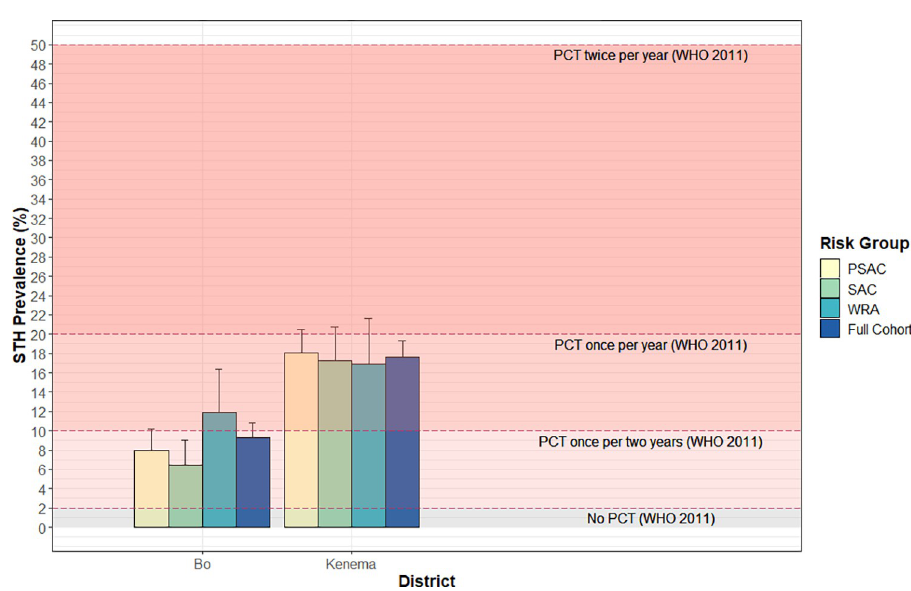
Fig 2. Soil transmitted helminthiasis prevalence by World Health Organization target risk group and thresholds for post-reassessment MDA frequency. STH: soil transmitted helminthiasis; PSAC: pre-school age children; SAC: school-age children; WRA: Women of Reproductive Age; Prevalence thresholds taken from Helminth control in school-age children : A guide for managers of control programmes . 2nd ed . Geneva : World Health Organization; 2011 , p . 74 .